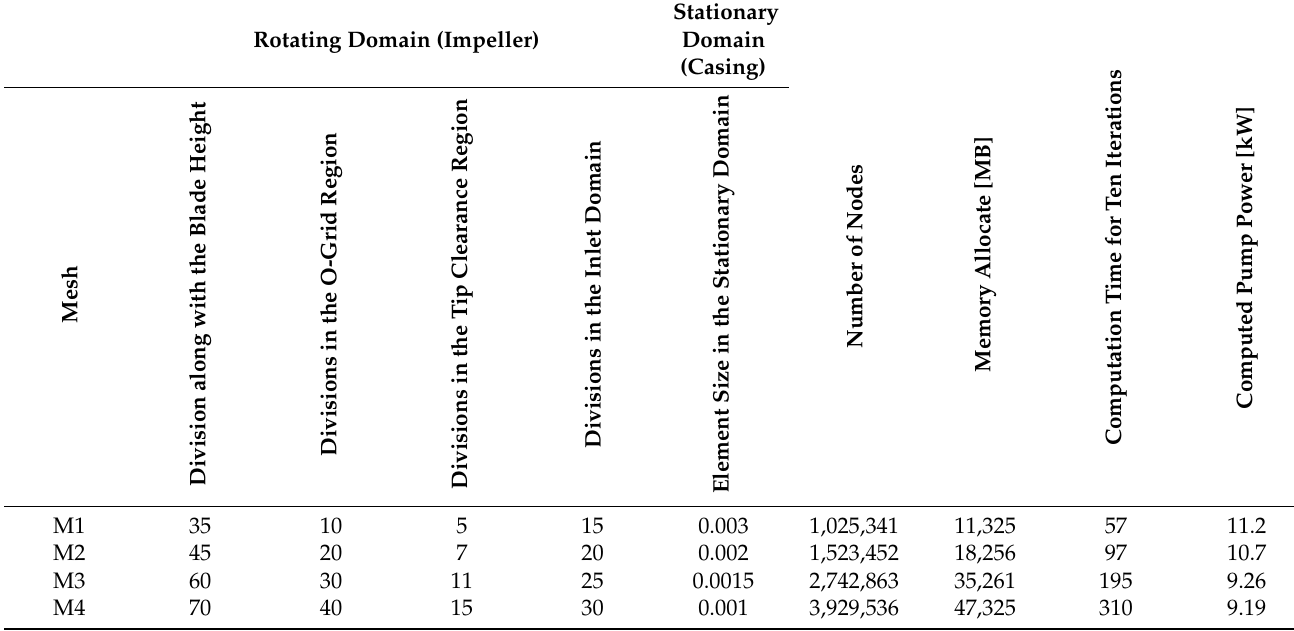
Table 2. Mesh details for the mesh optimization